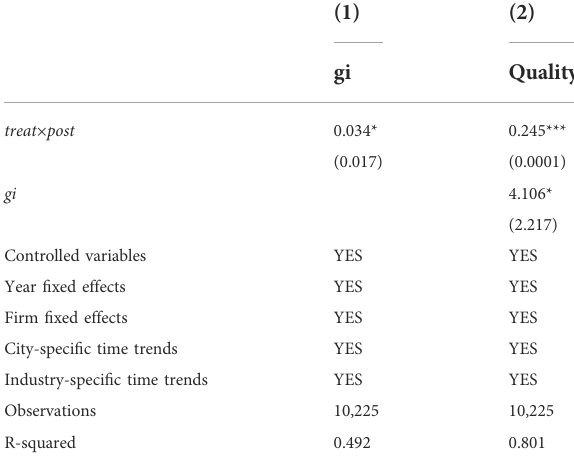
TABLE 6 Mediation effect of green